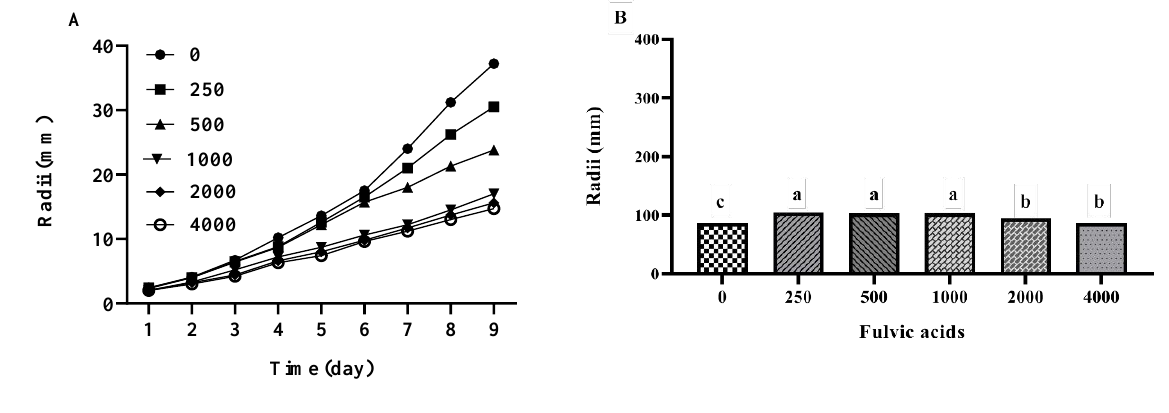
Fig. 7 Effect of different rates of fulvic acids extracts on Serendipita indica growth A, Dose-response curves for the growth of S. indica on solidified broth medium amended with seven concentrations of fulvic acids (0, 250, 500, 1000, 2000 and 4000 ppm L -1 ). ( Note: The diameter of fungus was divided by its average growth on four perpendicular axes bisecting the center of the colony. P < 0.05. Values are mean ± SE (n = 5). B , The mycelia mats (dry biomass) yield of S. indica growing in medium at seven fulvic acid levels (0, 250, 500, 1000, 2000 and 4000 ppm L -1 ). P < 0.05. Values are mean ± SE (n =